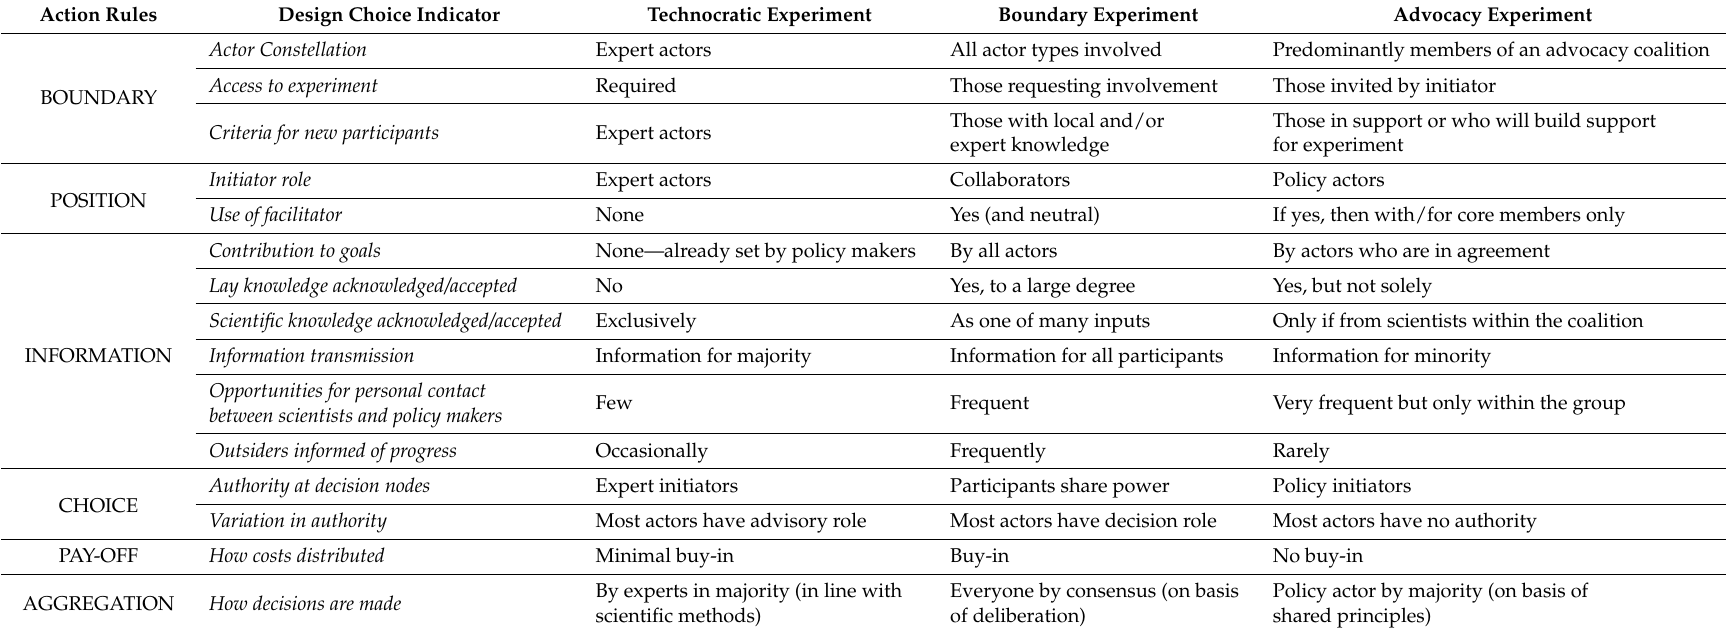
Table 2. Comparison of the characteristics of policy experiment ideal